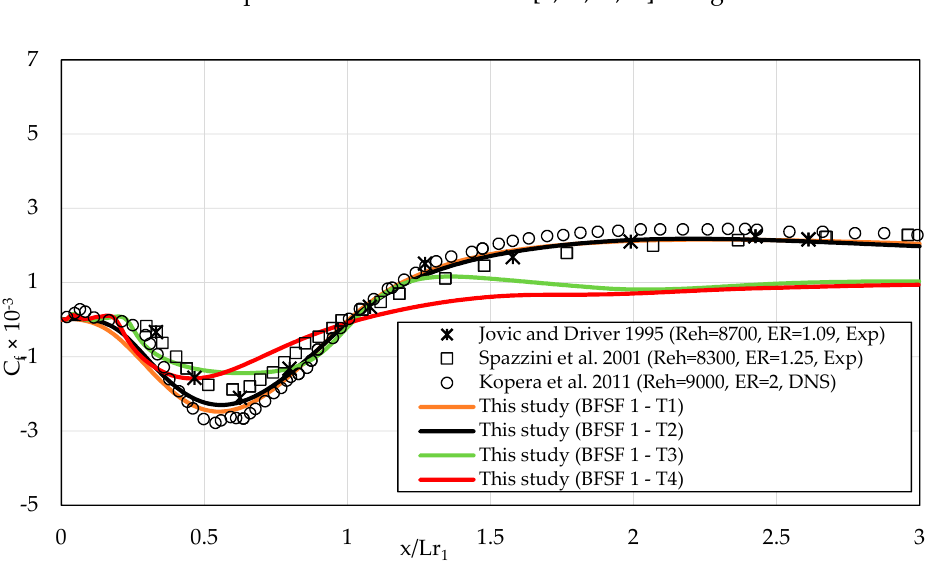
compared with the experimental data [15,16] and numerical results [26,37] (Figure 12). The present numerical results fit well with equation 13 and the literature